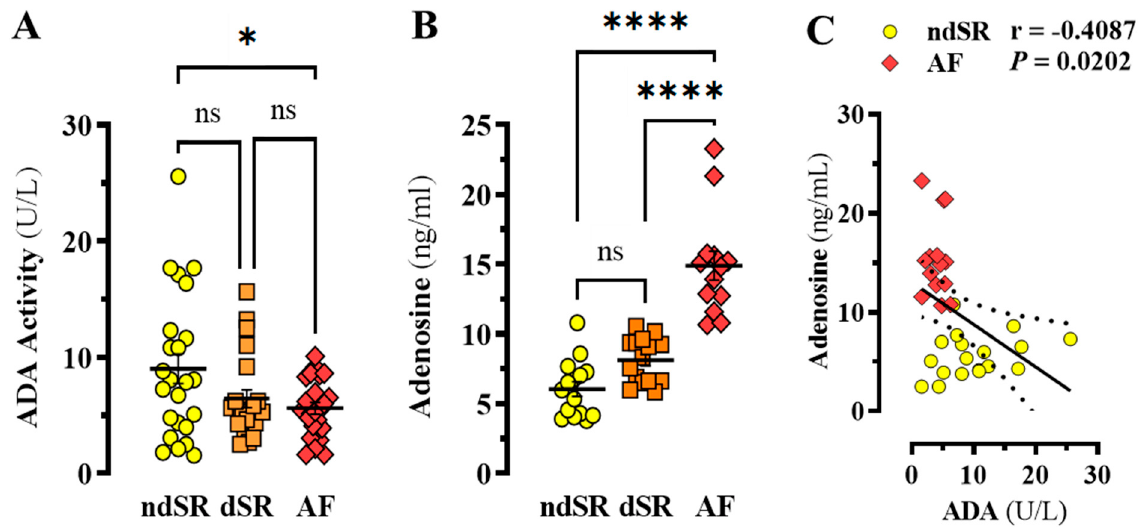
Figure 2. ADA activity and adenosine content in human plasma. ( A ) ADA activity in plasma from ndSR ( n = 24), dSR ( n = 22) and AF ( n = 23) patients was determined using the Dyazime kit. Two outliers were removed from the dSR group by the ROUT method ( see Materials and Methods). ( B ) Adenosine content in plasma from ndSR ( n = 15), dSR ( n = 15) and AF ( n = 13) patients was determined by MS-HPLC. One outlier was removed from the AF group by the ROUT method (see Materials and Methods). ( C ) Correlation between ADA activity and adenosine content in ndSR (yellow, n = 18) and AF (red, n = 14) patients. The correlation coefficients (r) were calculated using the Pearson’s two-tailed correlation test. The results are expressed as mean ± SEM. * p < 0.05 and **** p < 0.0001, one-way ANOVA with Tukey’s post-hoc